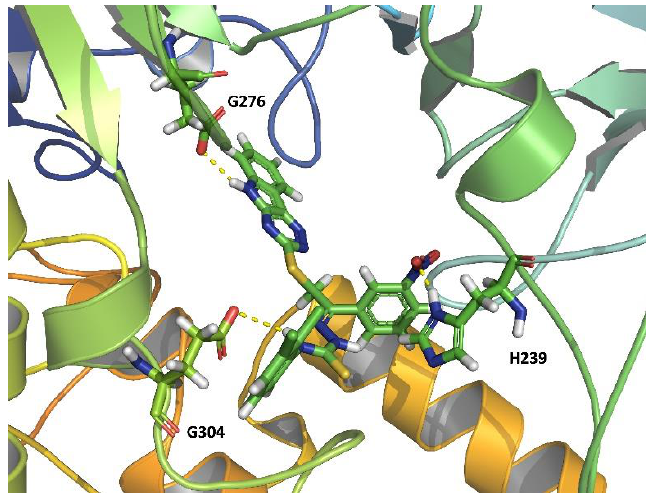
Figure 4. Docking position of compound 23 in the active site of the α-glucosidase enzyme .